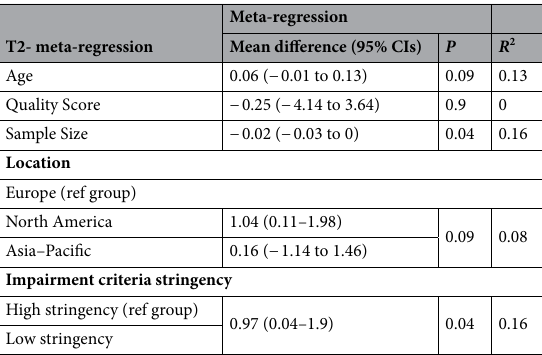
Table 4. Results of four individual meta-regression analyses at T2 based on age, quality score, location and cognitive impairment criterion